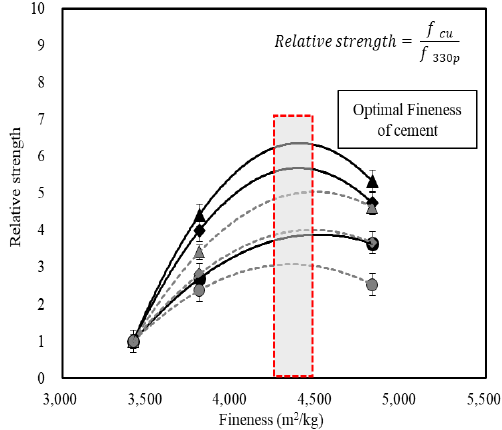
Figure 6. Relation between fineness of cement and compressive strength development.